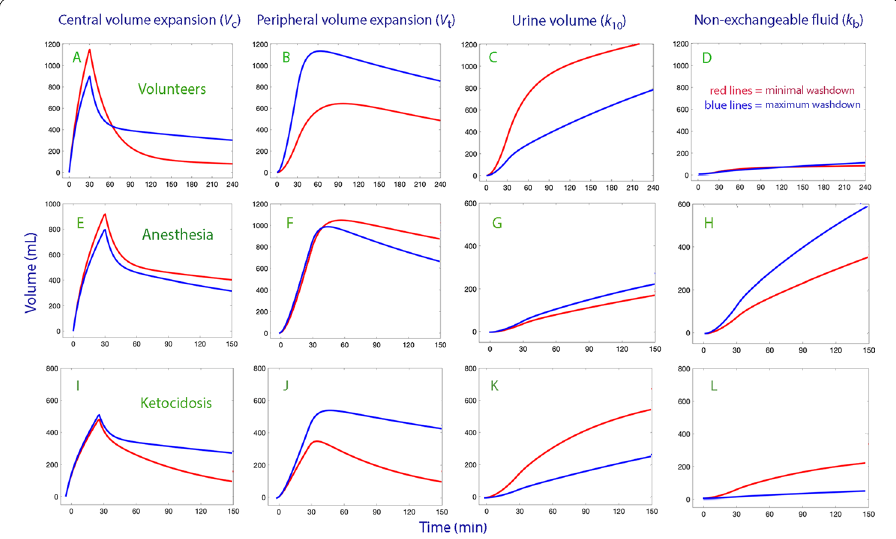
Fig. 4 Influence of interstitial washdown on the distribution of crystalloid fluid. Volume kinetic analysis of the fluid distribution when 1.7 L of Ringer’s was infused in volunteers (top row; subplots A – D ), 1.7 L to patients undergoing surgery (middle row; subplots E – H ) and 1.0 L of 0.9% saline was given to patients with ketoacidosis (bottom row; subplots I – L ). All infusions were given over 30 min. All volumes are shown depending on whether the interstitial washdown was in the low or high range (minimal to maximum washdown; approximately 5–95% span). For the volunteers, the range was between 0.019), for the anesthesia patients − the Hb–albumin difference in plasma dilution varied from